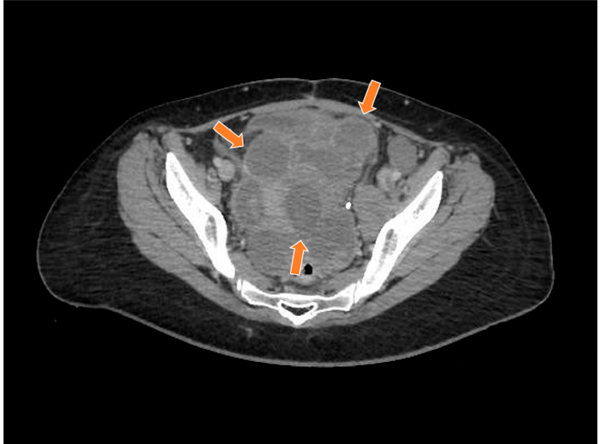
Figure 8. The computed tomography study in the portal phase showing a heterogeneous lesion in the pelvic region with cystic areas in between (orange arrows).